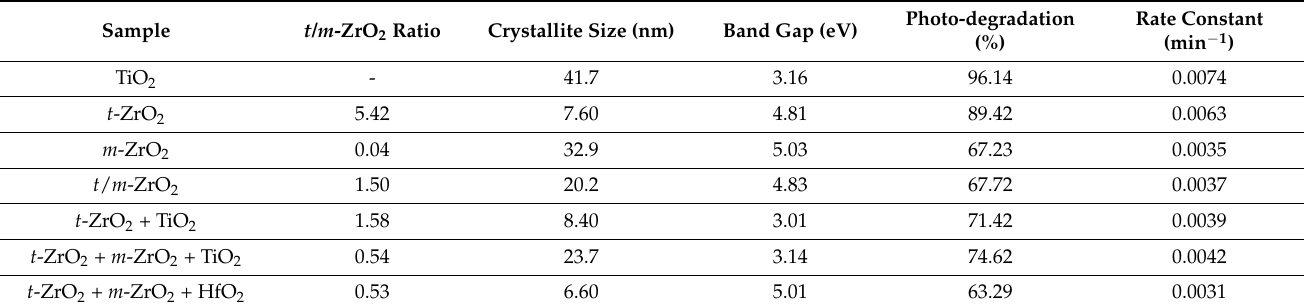
Figure 7. The concentration changes over measuring time ( a ) and the kinetics of photocatalytic degradation MO with different catalysts ( b ). Table 4. Properties of catalysts and their photocatalytic degradation of MO.